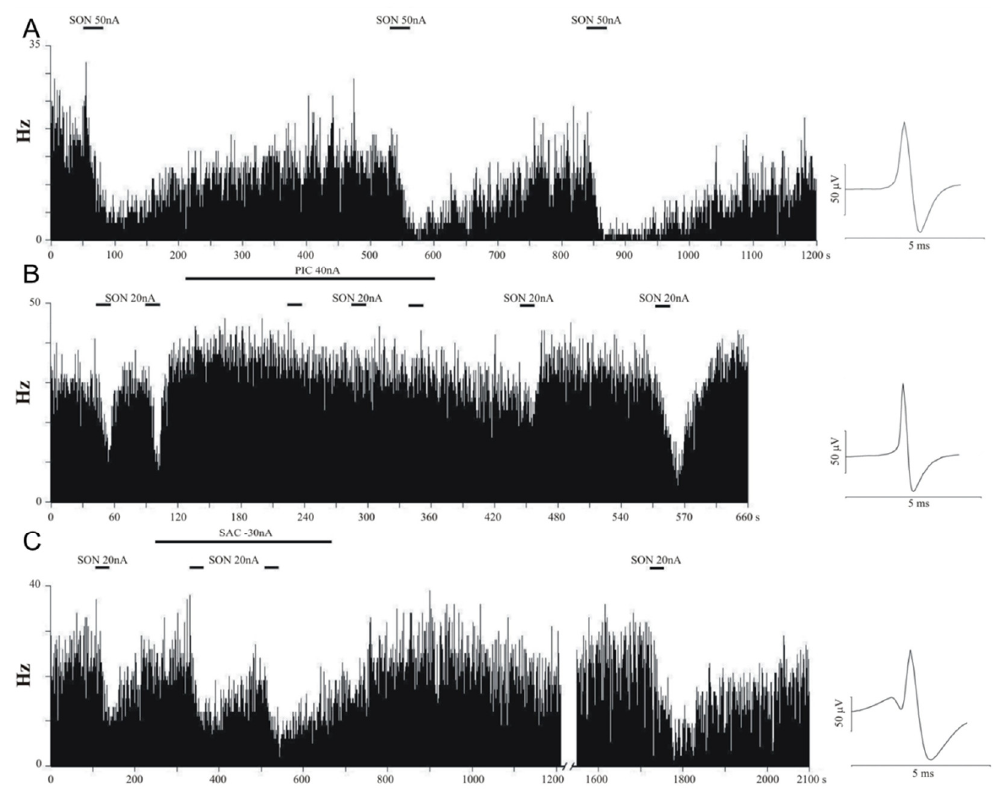
Figure 1. Frequency histograms of representative neurons from the rat forebrain. Microiontophoretic injection of songorine (SON) inhibited neuronal activity ( A ). After the termination of the ejection of SON, the spontaneous neuronal activity always returned. Picrotoxin (PIC) successfully blocked the inhibitory effects of SON ( B ). However, the application of saclofen (SAC) did not modulate the inhibitory effects of SON ( C ).